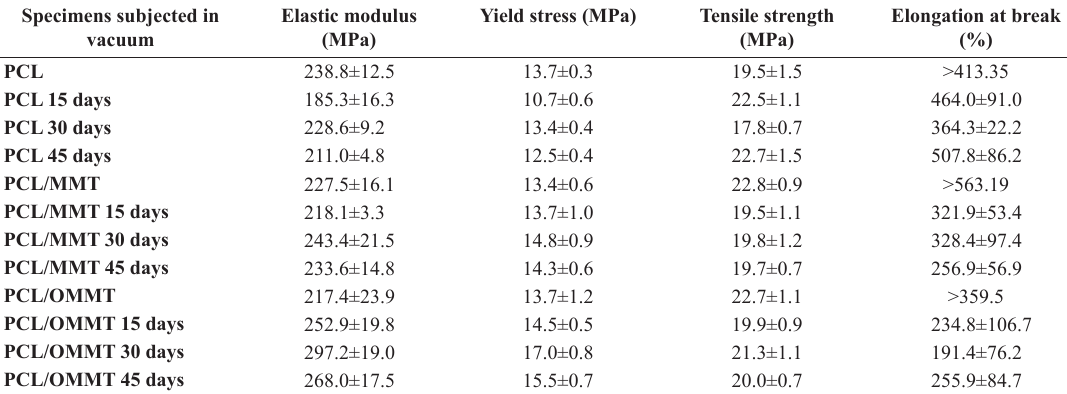
Table 2: Mechanical properties of PCL and PCL/MMT and PCL/OMMT compounds subjected into vacuum at 40 o C Specimens subjected in Elastic modulus vacuum